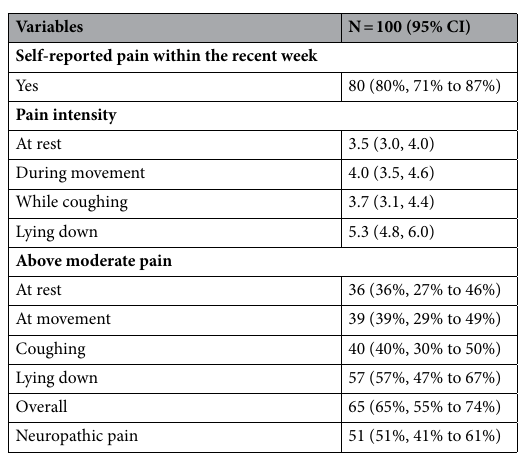
Table 2. Prevalence and characteristics of chronic pain. CI: confidence